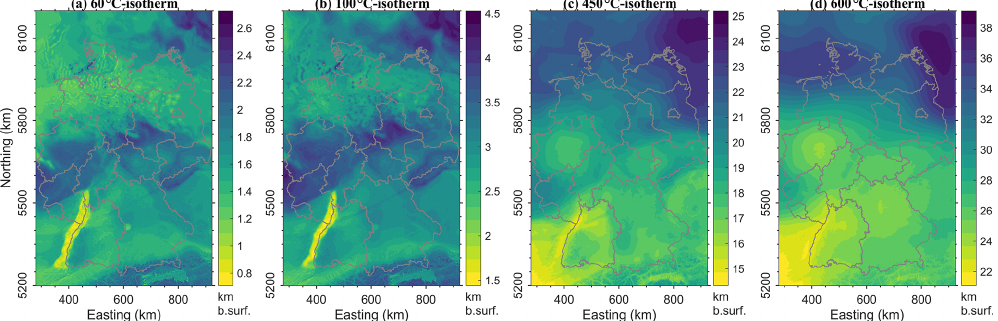
Figure 5. Depths of the isotherms: (a) 60 ◦ C; (b) 100 ◦ C; (c) 450 ◦ C and (d) 600 ◦ C. Colour bars show depth in km below earth’s surface.